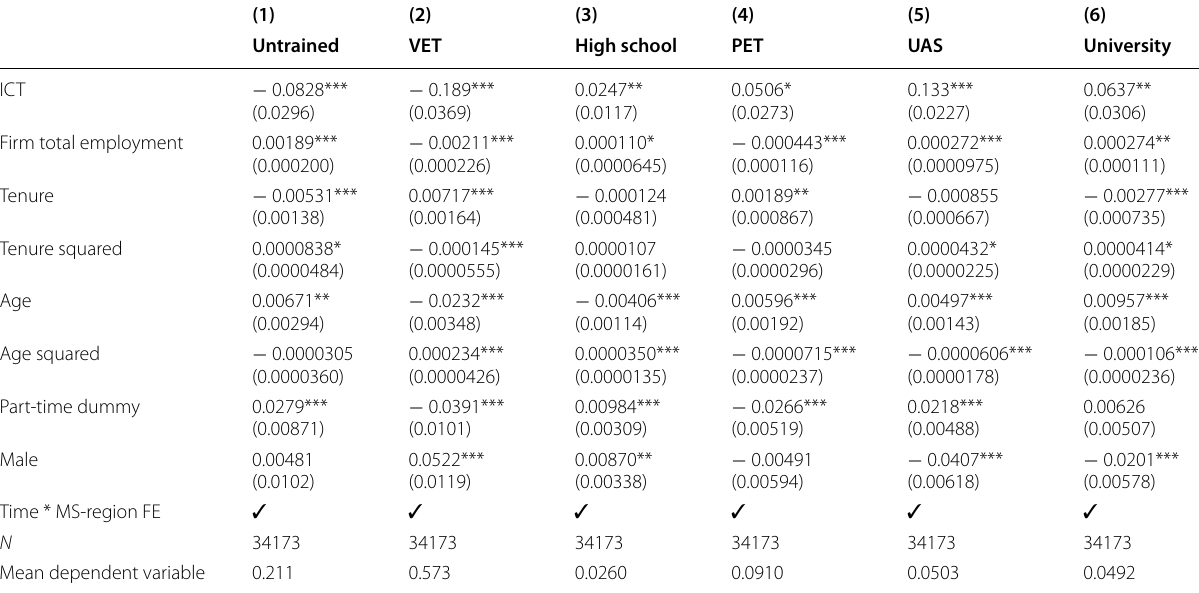
The table shows OLS coefficients of fixed effects estimates of a firm pseudo-panel with cells defined based on MS-region, industry, and firm size. Standard errors in parentheses are clustered at the cell level. N reports the number of pseudo-panel cells that contain at least one firm. The main explanatory variable measures the cell percentage of ICT workers according to ICT tasks (1996–2010) or ICT occupations (2012–2018). Estimates further control for time*MS-region fixed effects and cell averages of total employment, tenure, age, part-time status, and gender. Each column shows the results for a different dependent variable measuring the percentage of workers with a particular education within the